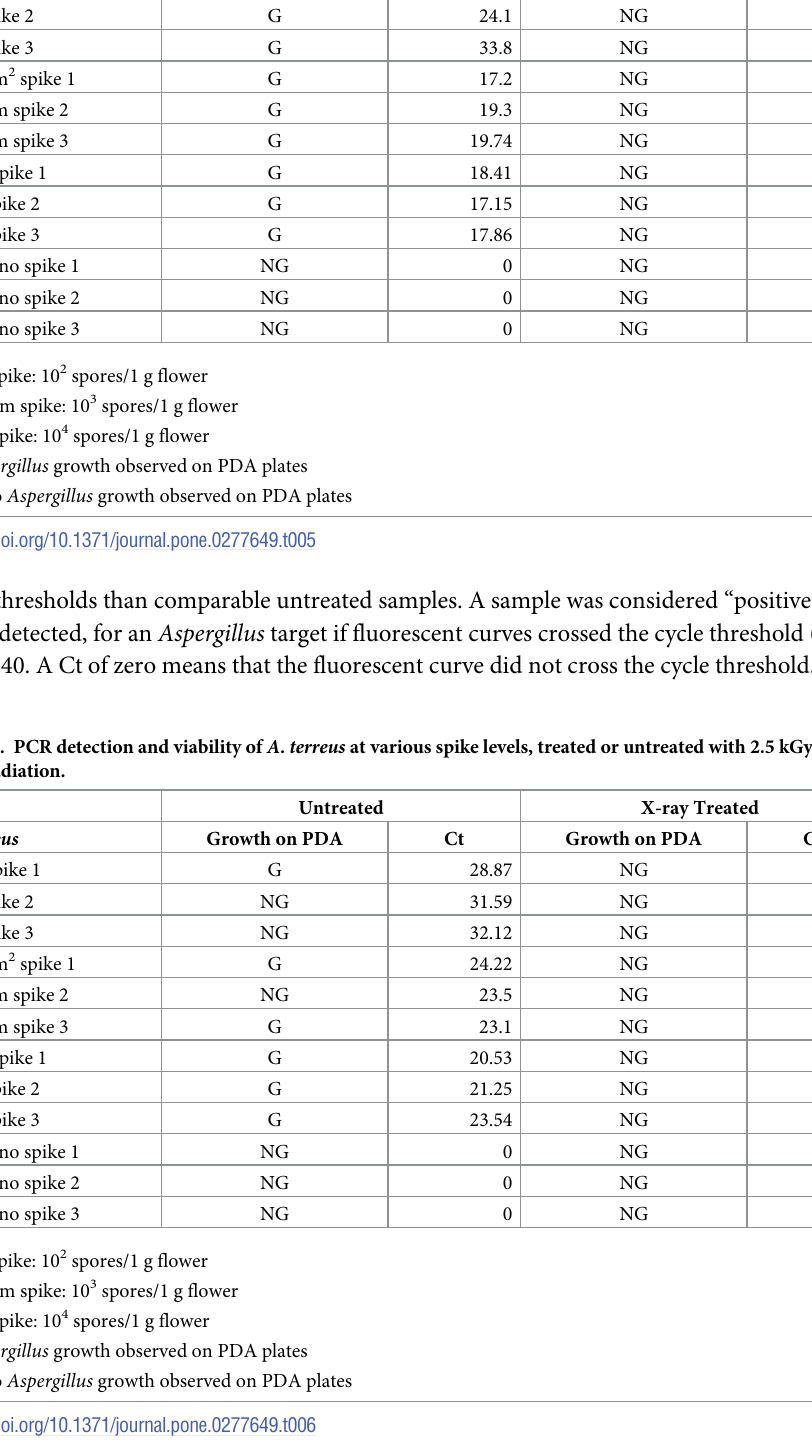
Table 5. PCR detection and viability of A . flavus at various spike levels, treated or untreated with 2.5 kGy of X-ray irradiation. Untreated X-ray Treated A . flavus Growth on PDA Ct Growth on